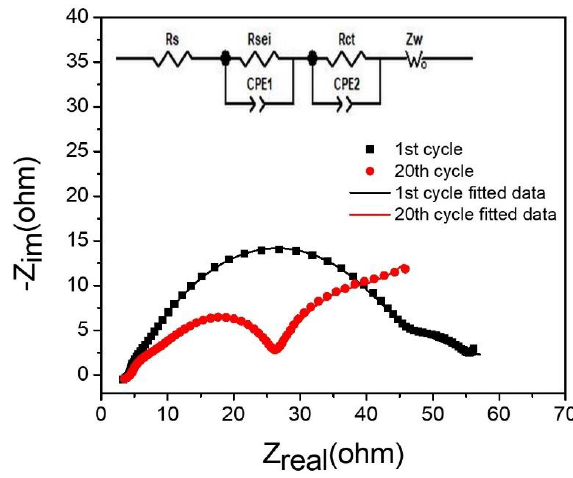
Figure 5. Electrochemical impedance spectra (EIS) and its equivalent circuit diagram for 8 h milled Si/C nanocomposite